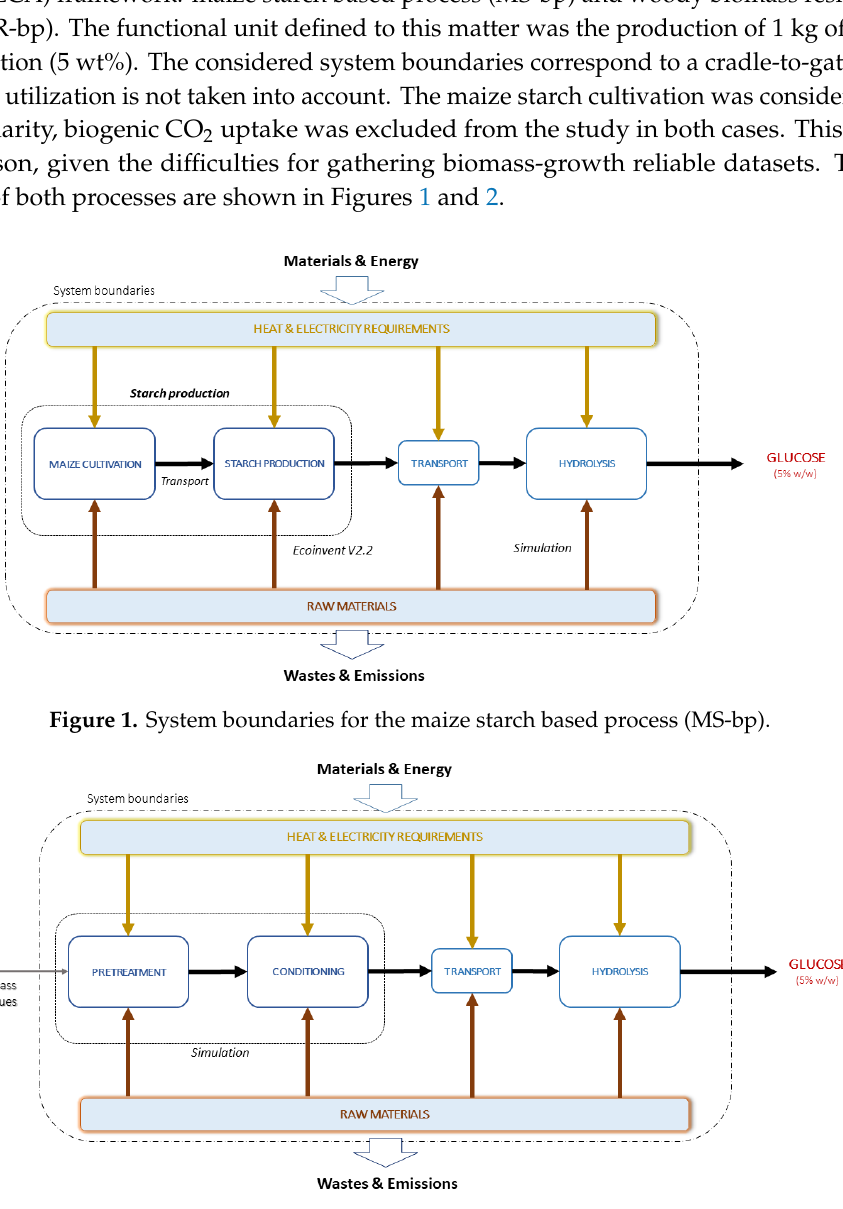
Figure 2. System boundaries for the woody biomass residues based process (WBR-bp).